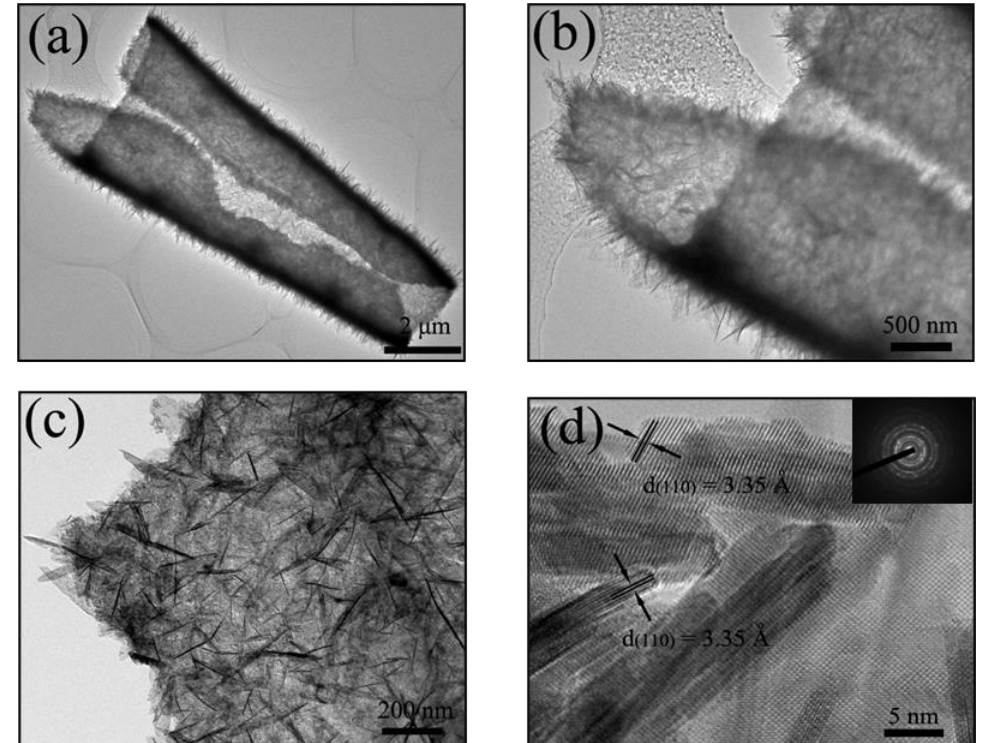
Figure 5. ( a – c ) Typical TEM images of the nanosheets SnO 2 ; ( d ) HRTEM images of the nanosheets SnO 2 . The inset of d shows that these nanosheets are polycrystalline. SnO 2 . The inset of d shows that these nanosheets are